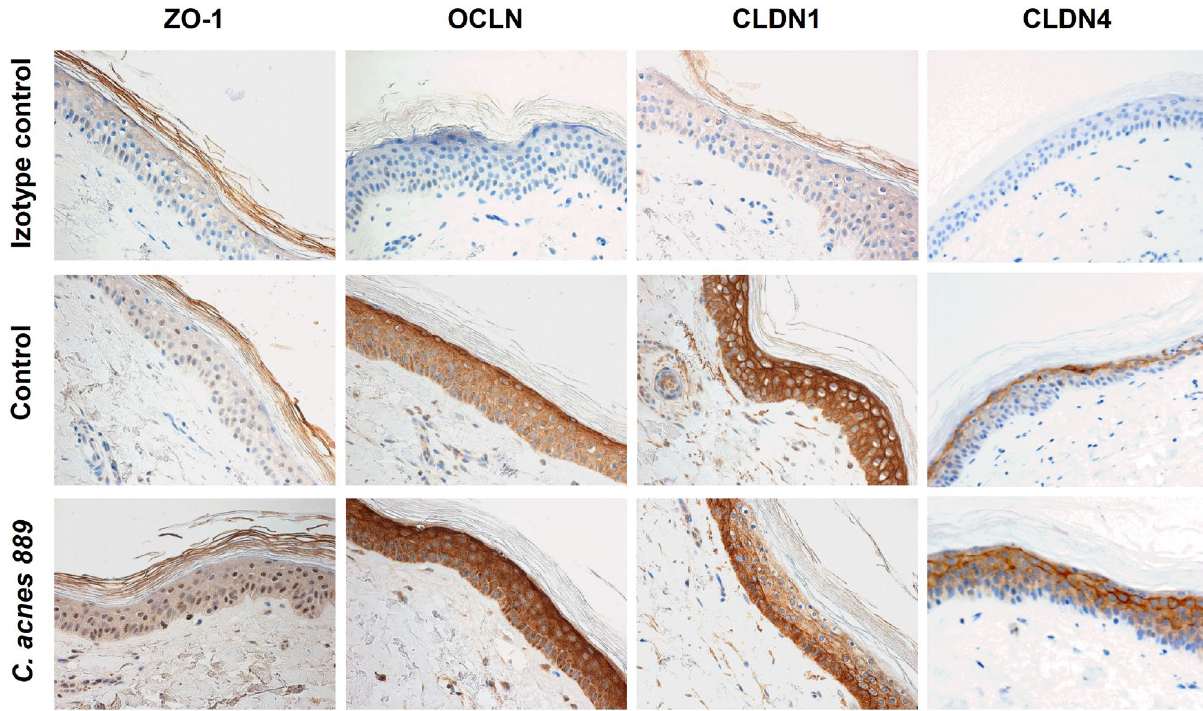
Figure 5. TJ protein expression changes in OS models upon treatment with C. acnes 889 strain. Full-thickness skin biopsy samples were treated with live C. acnes strain 889 (1.5 × 10 7 bacteria/sample) for 72 h. Paraffin- embedded sections were analysed by IHC staining. We detected marked changes in expression and tissue localization for all the analysed TJ proteins 72 h after bacterial treatment. (Representative image of three independent experiments).